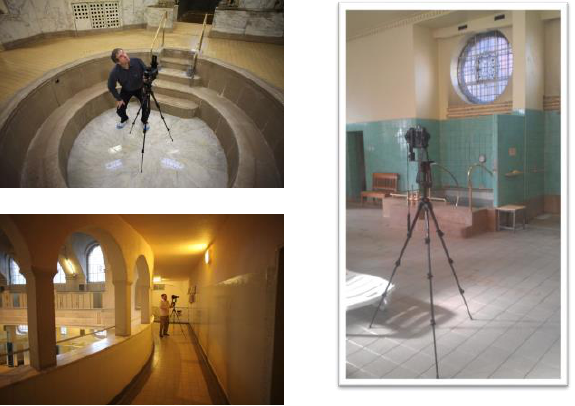
Figure 3: Shooting of photographs in interior lighting